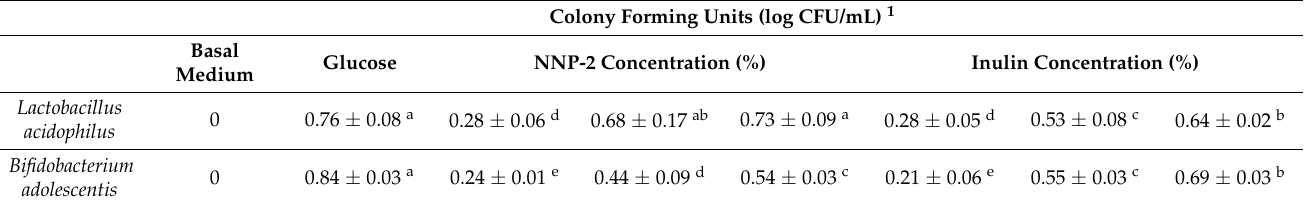
Table 3. Bacterial counts of commercial probiotics at 37 °C for 24 h on MRS basal medium culture.